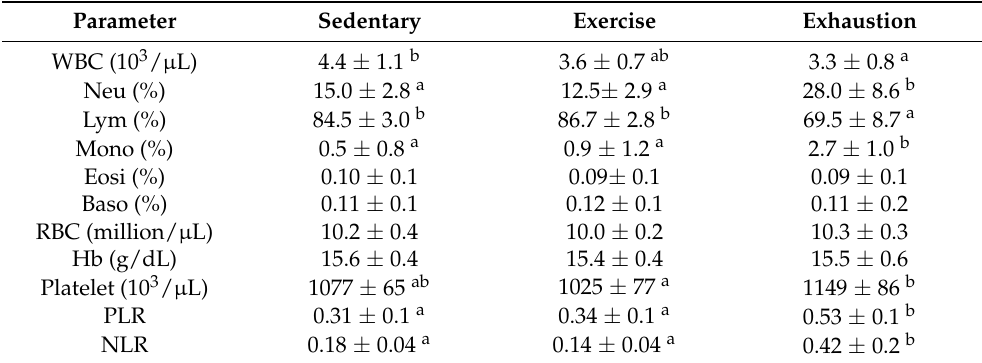
Table 3. Effects of consecutive exhaustive exercise intervention on complete blood count analysis.